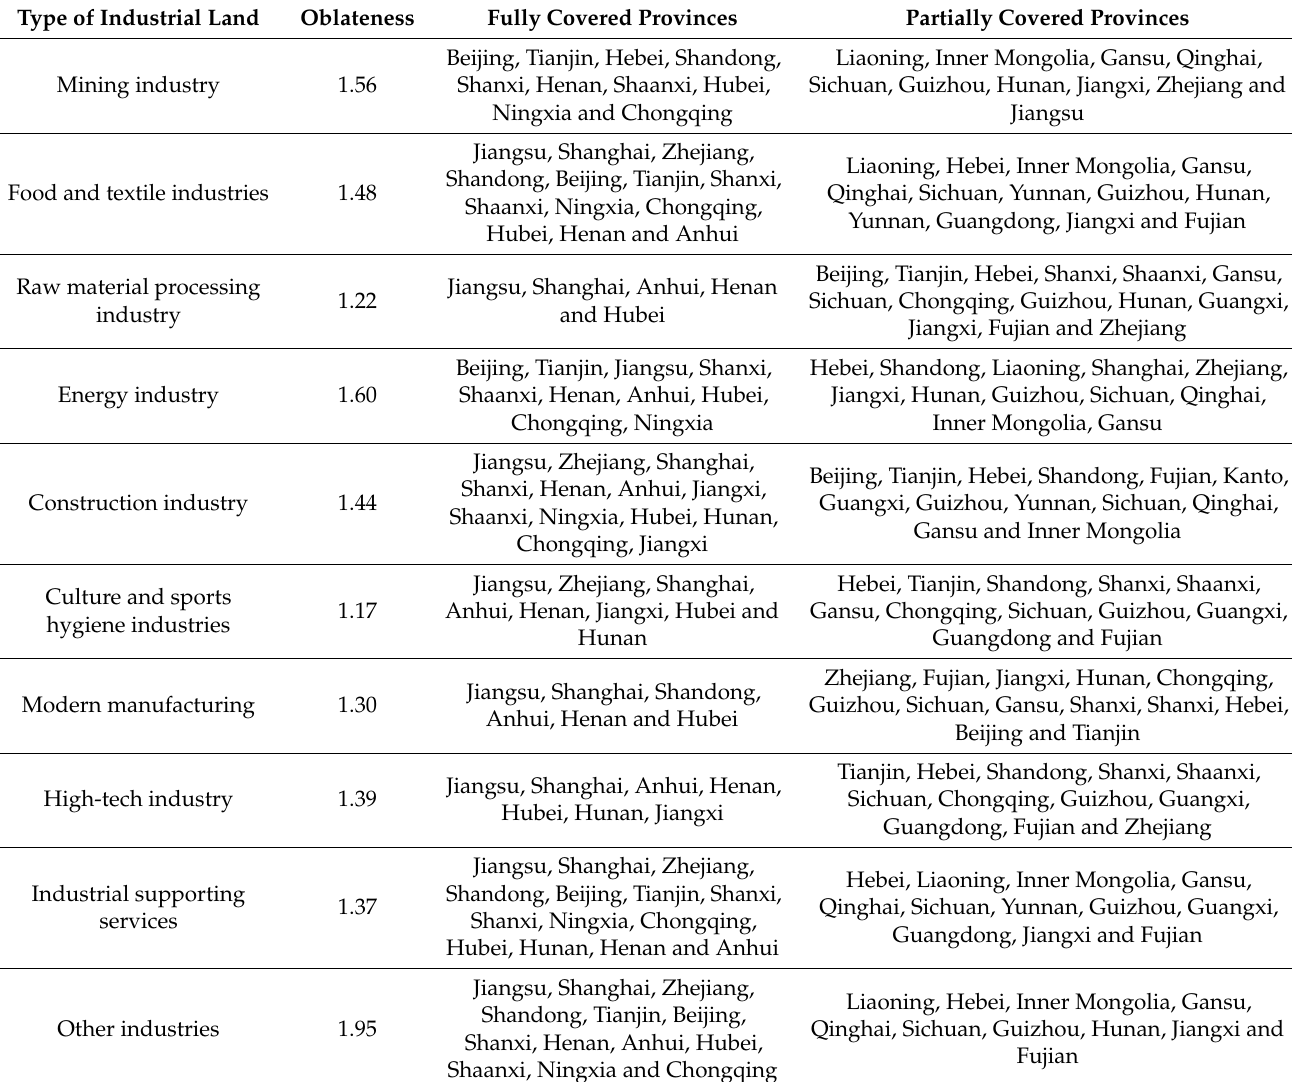
Table 4. Ratio of major and minor half axes of various transferred industrial land in